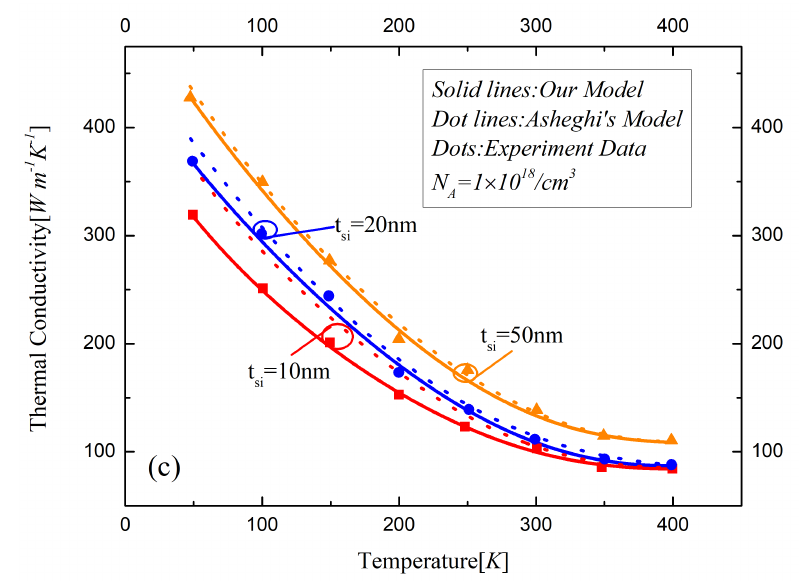
Figure 1. The thermal conductivity of the ultra-thin silicon film material with different thickness and various doping concentration considering the influence of temperature ( a ) N A = 1 × 10 17 /cm 3 , ( b ) N A = 5 × 10 17 /cm 3 , ( c ) N A = 1 × 10 18 /cm 3 .